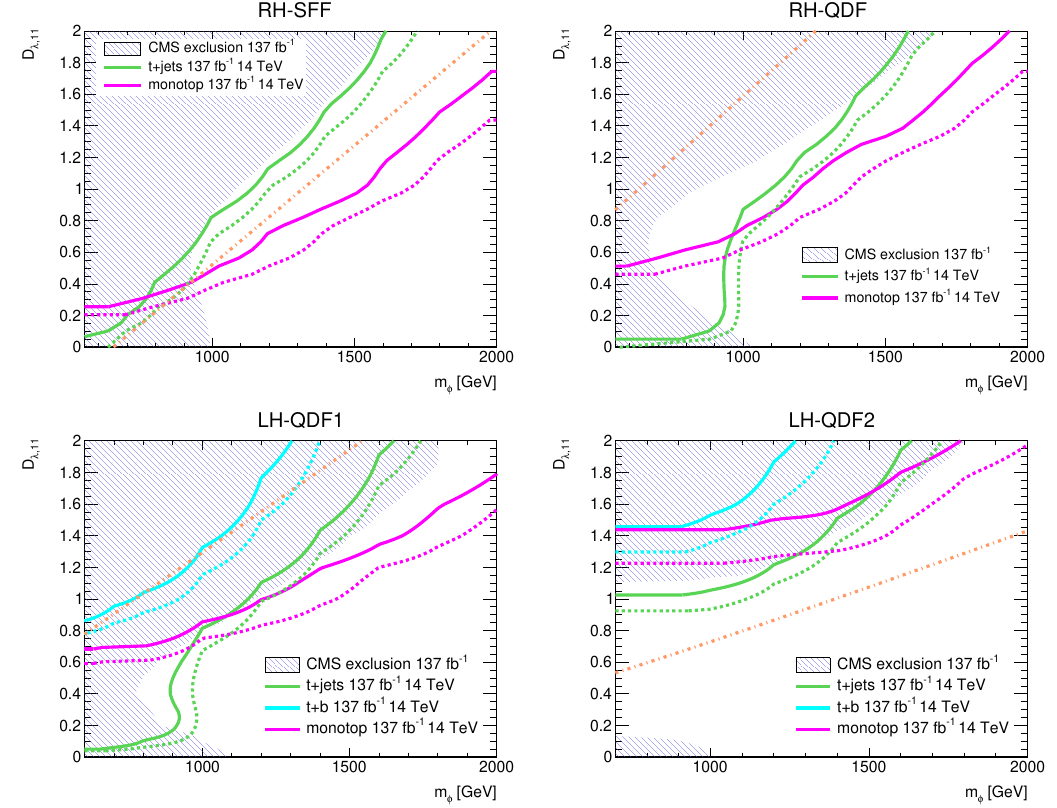
Figure 13 . Full lines: excluded areas in the ( m φ , D λ, 11 ) plane for the tj , tb and monotop analyses proposed in this paper for an integrated luminosity of 137 fb − 1 at a 14 TeV LHC. The excluded areas are on the left of the curves. The dashed lines show the corresponding results for 300 fb − 1 . The shaded area corresponds to the region excluded by the CMS analyses. The orange dash-dotted lines indicate for which set of parameters the correct relic abundance is